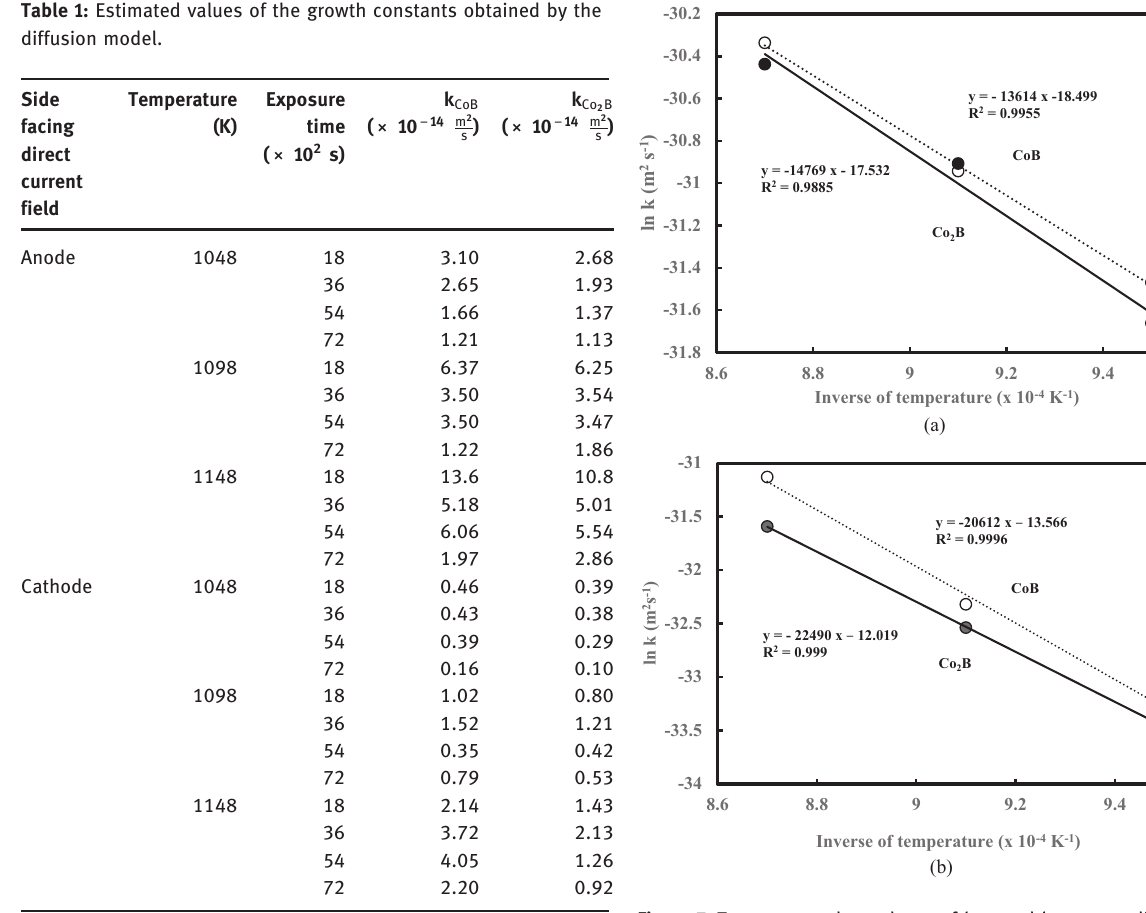
Figure 7: Temperature dependence of k CoB and k Co Arrhenius equation: (a) surface exposed at the anode, (b) surface exposed at the cathode. Table 2: Boron activation energies ( Q ) estimated in CoB and Co 2 B